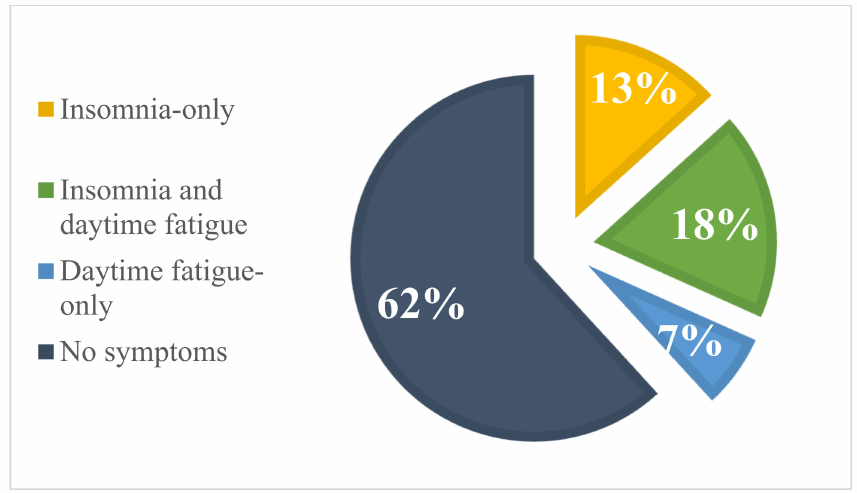
Figure 2. Prevalence of subgroups in all patients ( n =